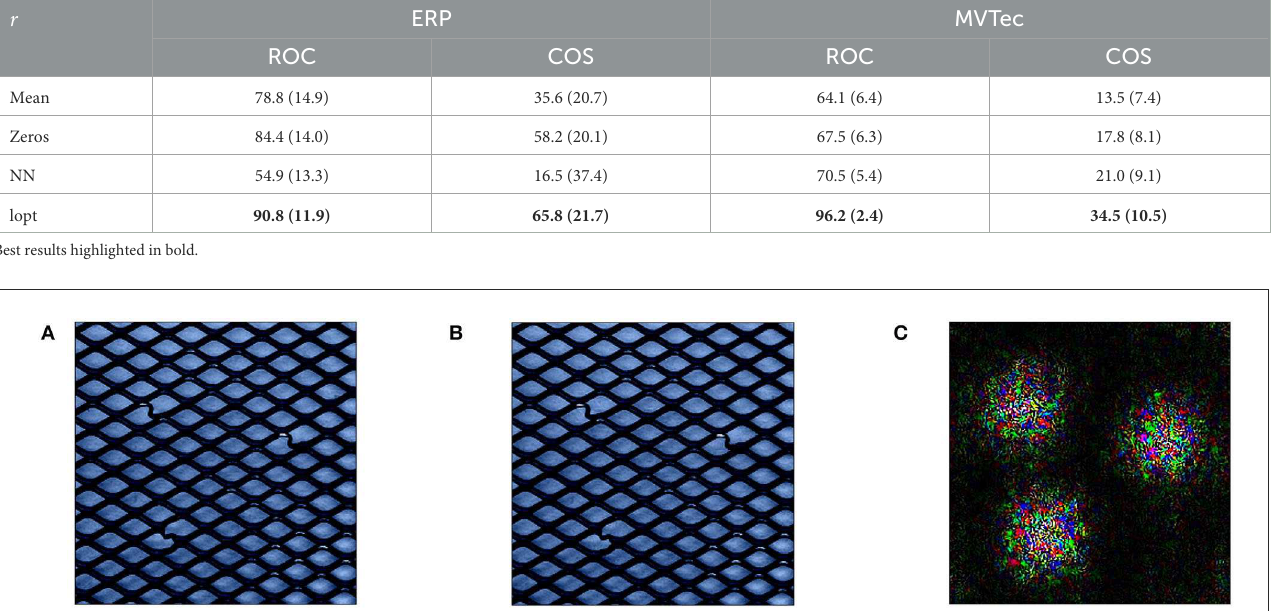
FIGURE5 Generating reference r through Equation (11) on MVTec: similar to the perturbation issues described in Section 4.3, Equation (11) generates reference points r (B) that are visually indistinguishable from x (A) . We again visualize the amplified change in pixel values in (C) .